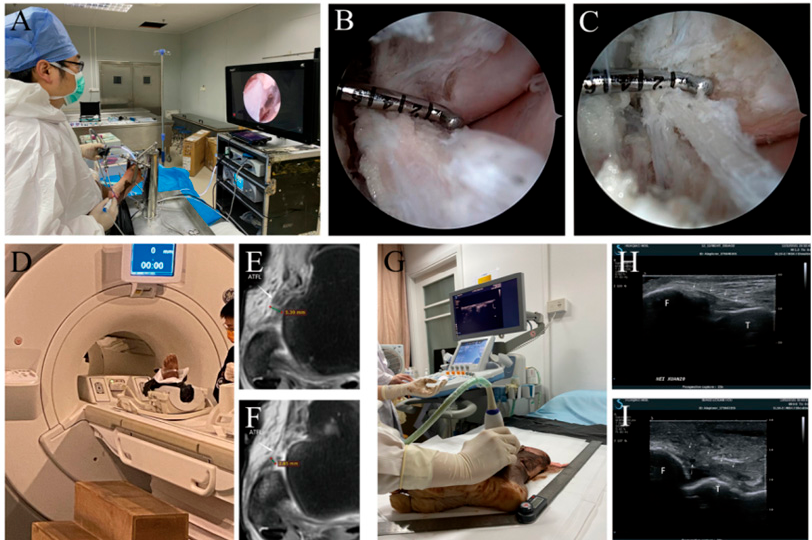
Figure 1. Establishment of most ATFL injury models. ( A – C ): the severe ATFL injury model was established under total arthroscopy. ( D – F ): MRI confirmed successful modeling before and after operation. ( G – I ): B-ultrasound confirmed successful modeling before and after operation. MRI: magnetic resonance imaging.